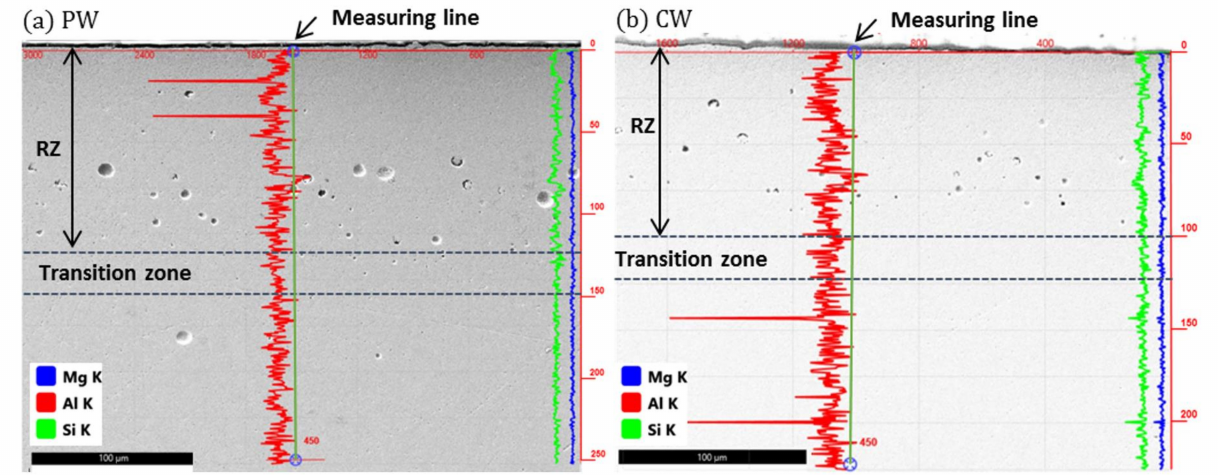
Figure 15. Chemical composition in vertical direction from the surface through the remelting zone (RZ) and L-PBF initial state. ( a ) PW, ( b ) CW.